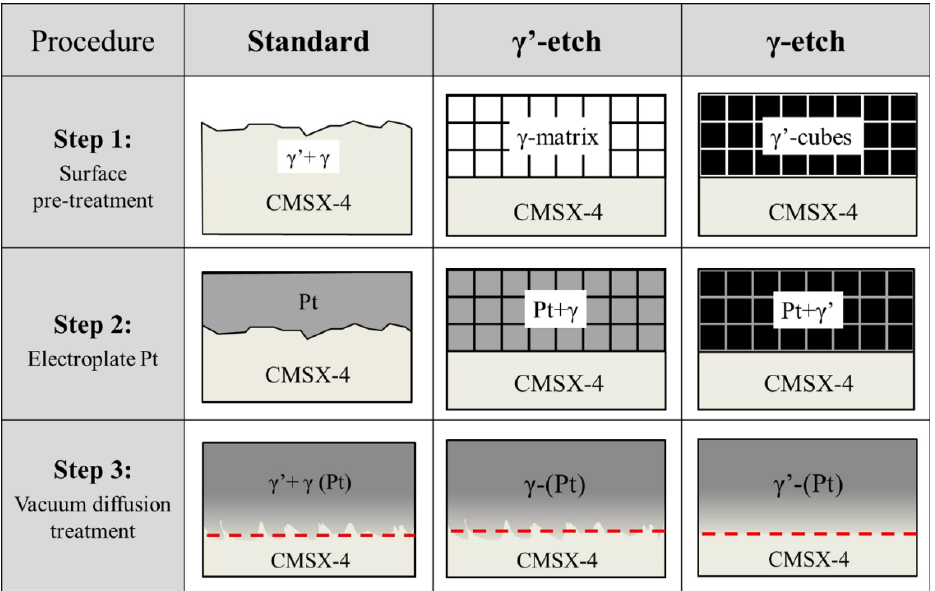
Figure 1. Schematic illustrations show the microstructural evolution on the cross-sections of single-phase Pt-diffused bond coat fabricated by selective etching.